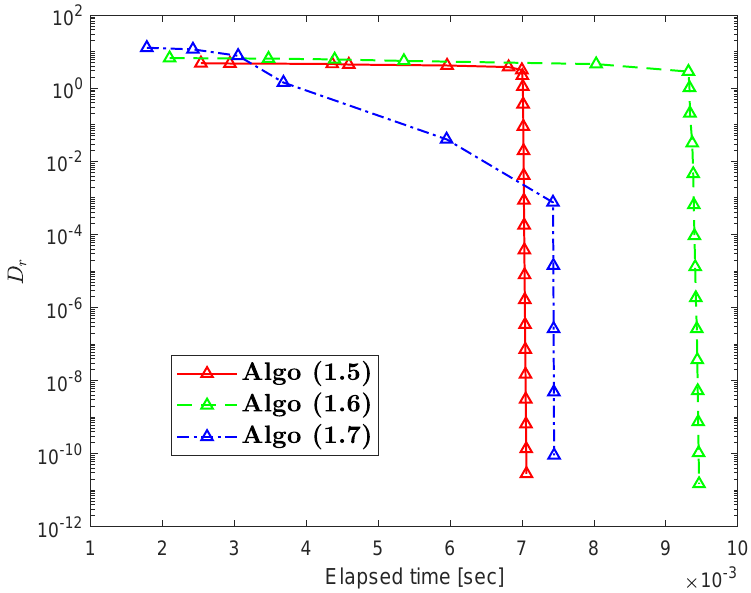
Figure 6. A graphical comparison of Algorithms (5)–(7), where z 1 =